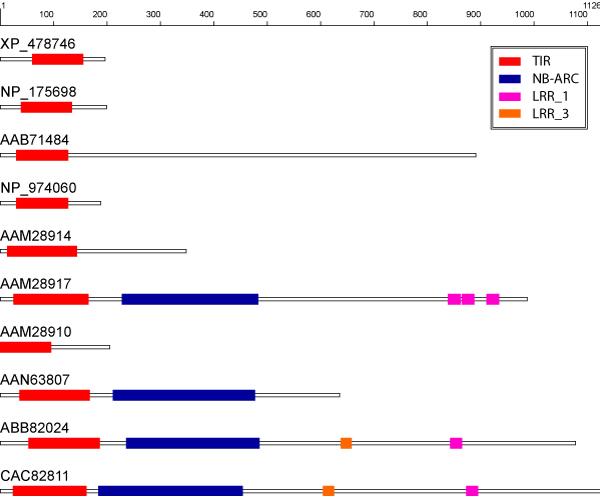
Analysis of rice protein XP_478746 and BLAST hits. The PFAM domain architectures of XP_478746, annotated as a "TIR/P-loop/LRR disease resistance protein-like protien" (sic) from Oryza sativa, and its closest BLAST homologs are shown. XP_478746 contains a TIR domain only with no room for the P-loop and LRR regions; the sequence is therefore misannotated. We expect XP_478746 was annotated based on local similarity to a sequence such as AAM28917 (annotated as a "putative TIR/NBS/LRR disease resistance protein" from Pinus taeda), which does contain the NB-ARC and LRR domains. See text for details.